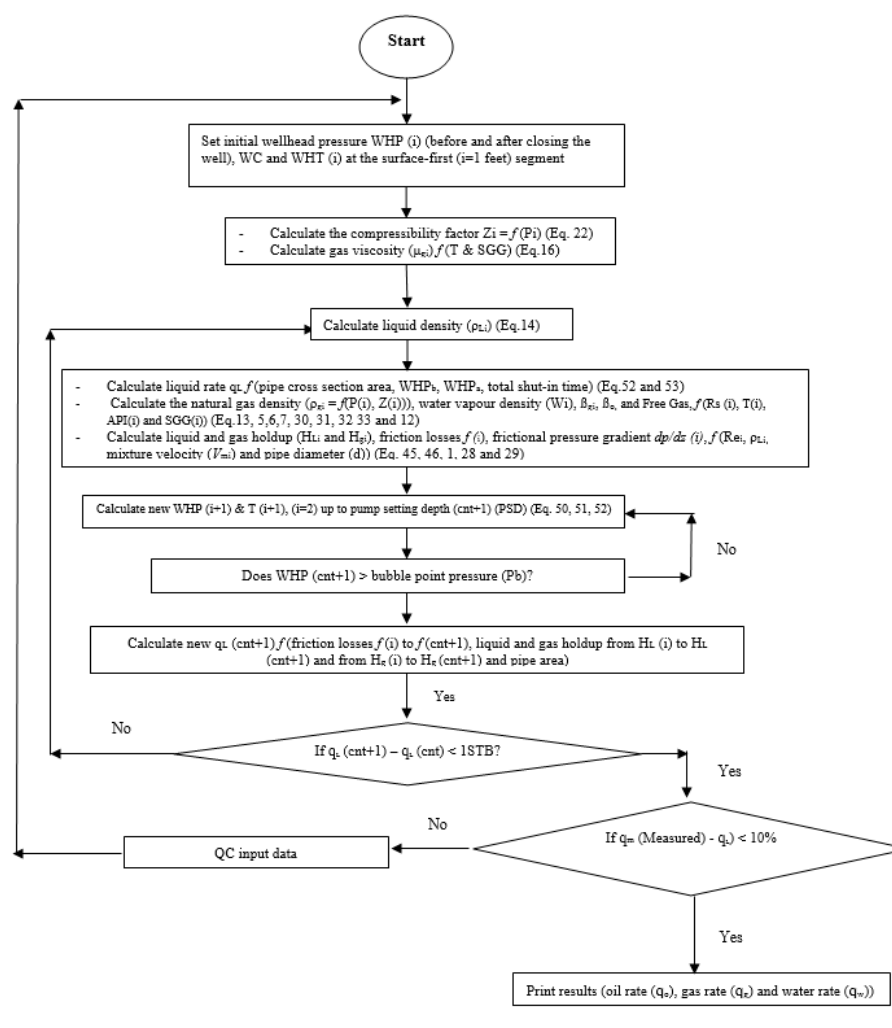
Figure 4. Flowchart of the new mathematical model algorithm.